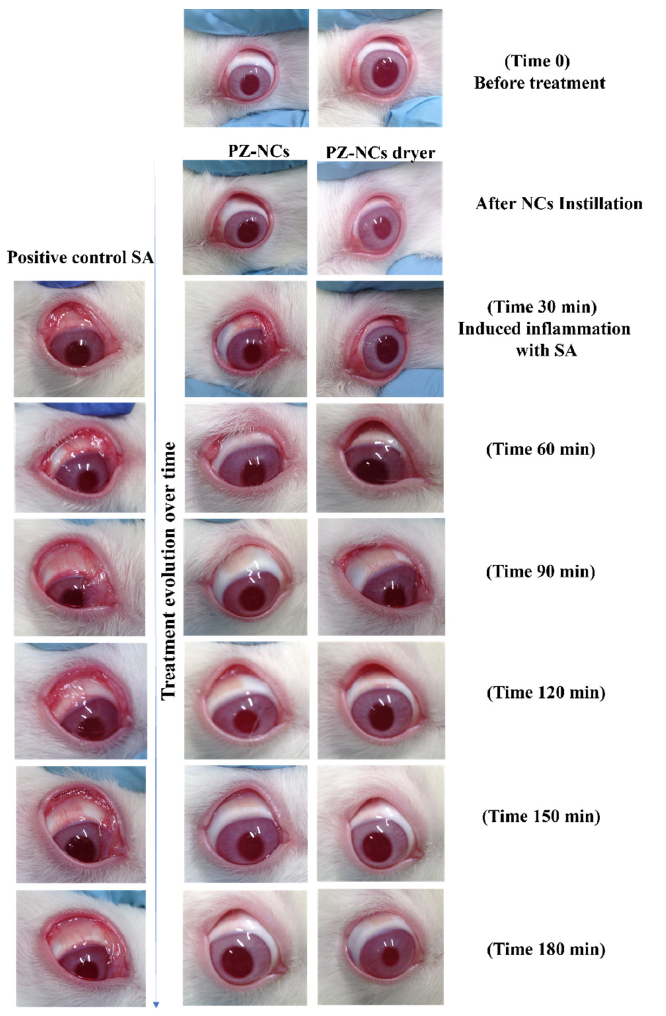
Figure 2. Anti-inflammatory efficacy of different formulations containing PZ in the ocular edema induced by instillation of sodium arachidonate (SA). Time 0 = negative control (without treatment). Regarding histological studies, it is possible to observe the corneal structure in Figure 3. The pictures confirm that the tissue and structure were preserved using both formula- tions of NCs. The epithelium (1) and the own laminate (3) are separated by a thin layer was not affected, and the epithelium (1) cells were not altered by any of the formulations tested.